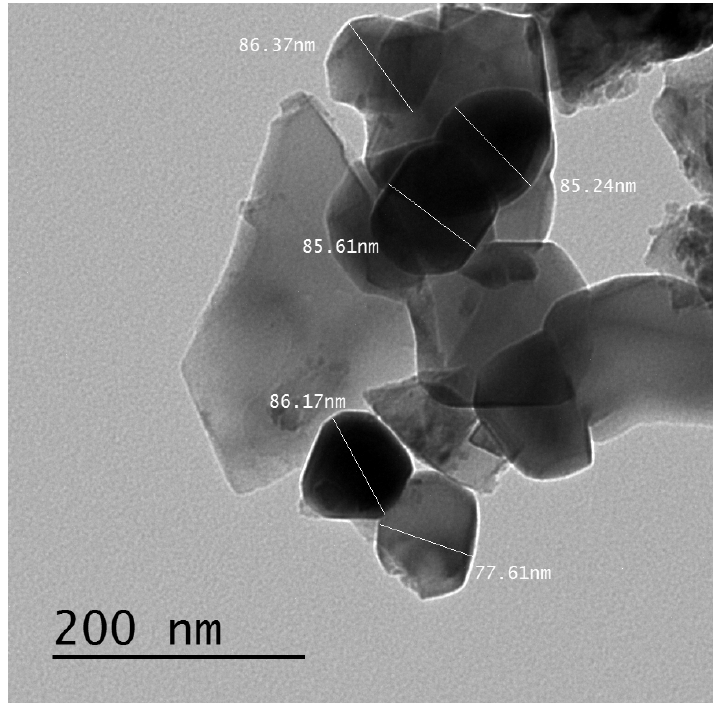
Figure 1. The transmission electron microscopy image for the obtained ferrite nanopowder.